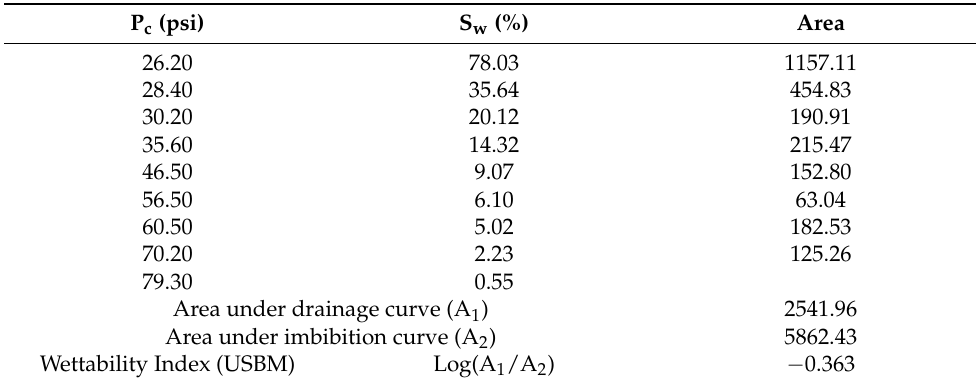
Table A1. Area under the curve calculation using trapezoidal rule for dolomite